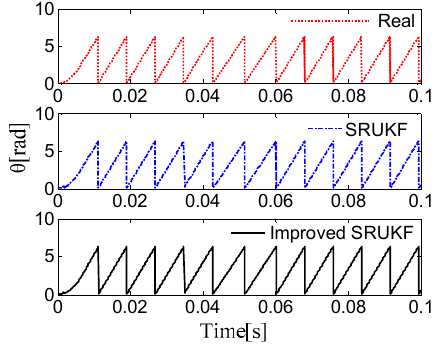
Figure 5. Speed estimation at 800 rad/s. Energies 2016 , 9, 489